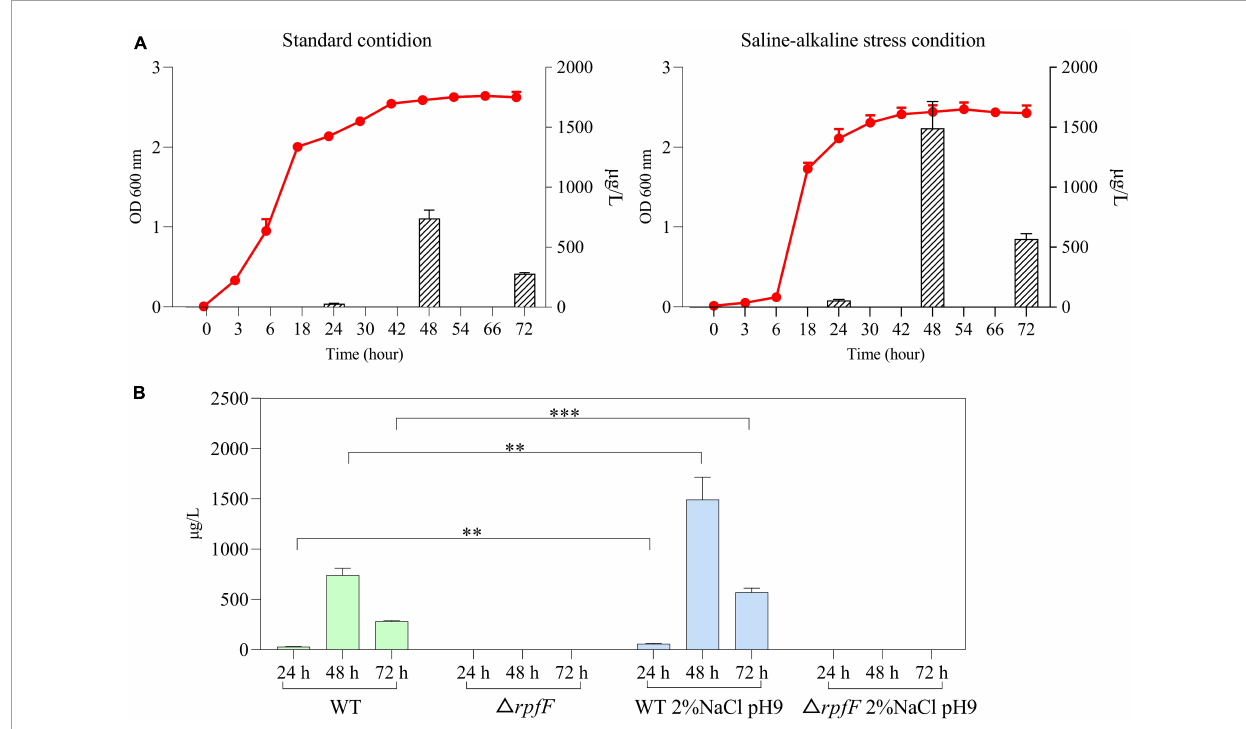
FIGURE2 (A) Growth and DSF secretion of S. rhizophila WT under standard condition and saline-alkaline stress. The red curve represents the bacterial growth curve, and the bar graph represents the amount of DSF secretion. Error bars indicate ± SD, n = 3. (B) Detection of DSF in S. rhizophila WT and (cid:49) rpfF under standard conditions and saline-alkaline stress. Error bars indicate ± SD, n = 3, ∗∗ P < 0.01, ∗∗∗ P < 0.001 (independent sample t